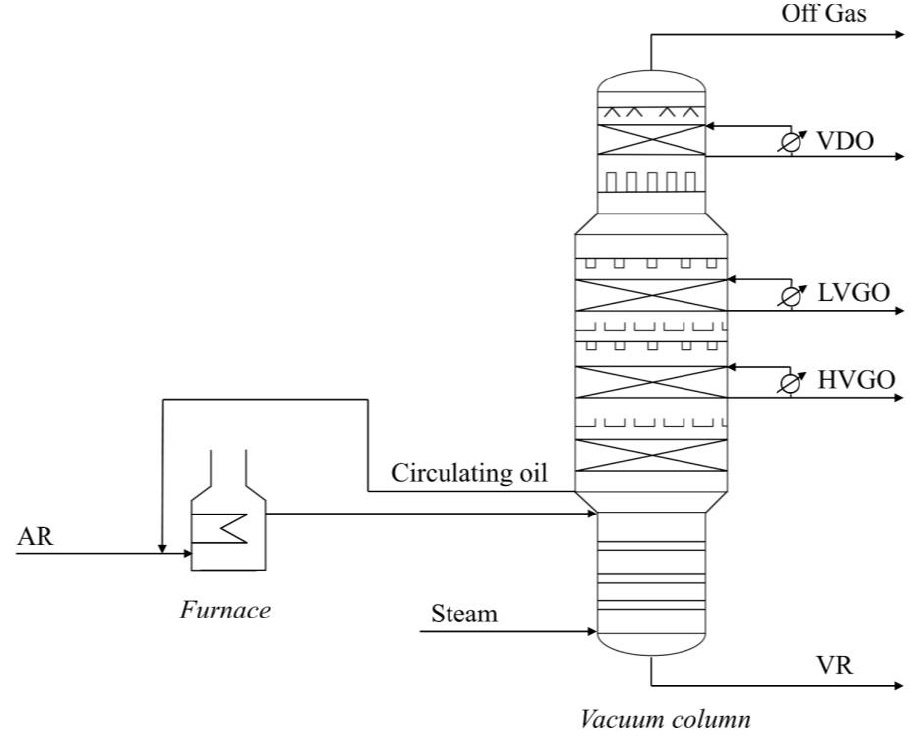
Figure 1. Process flow diagram of VDU.